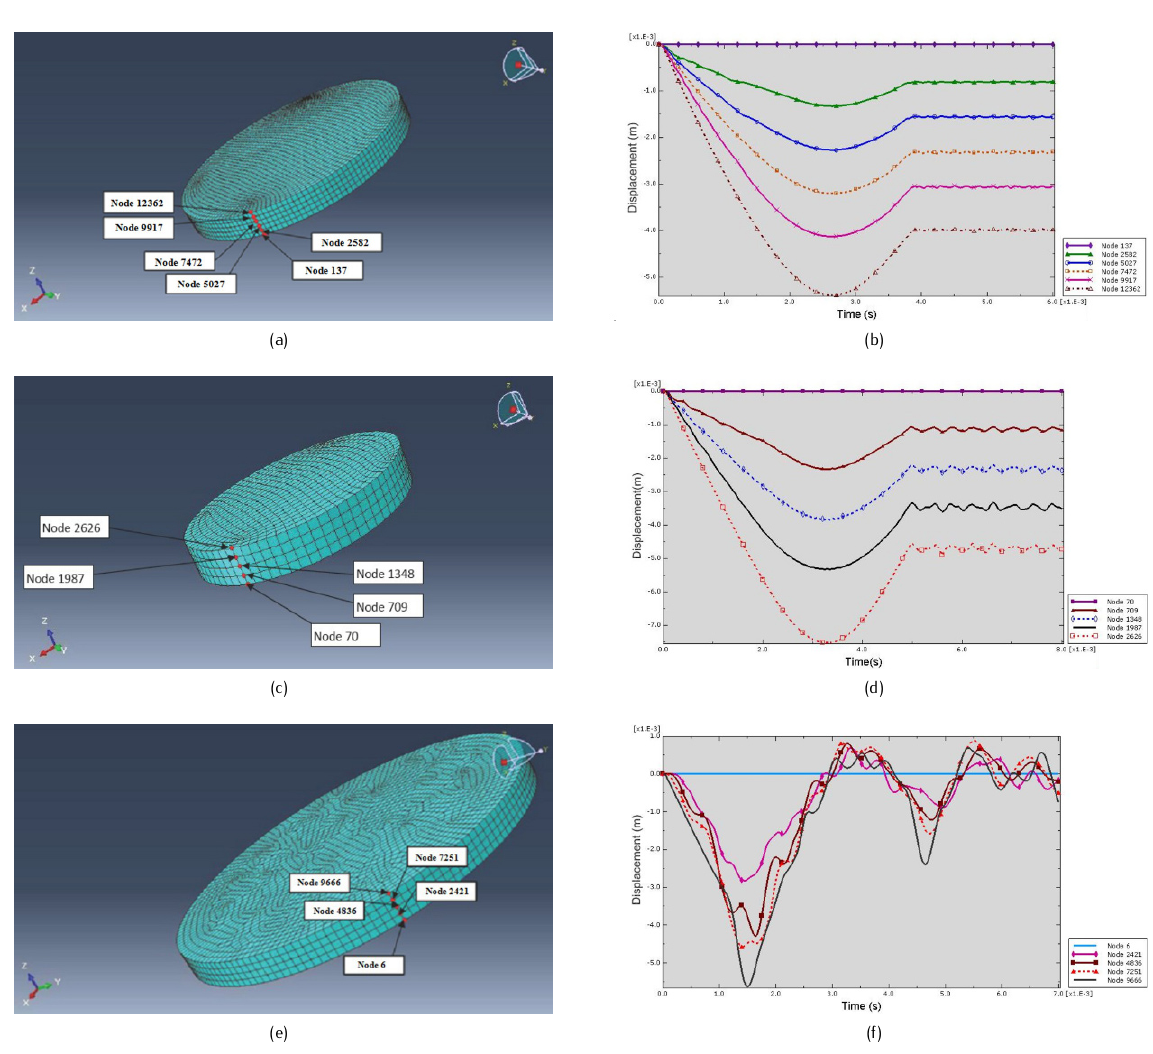
Figure 17. Compression profile: general views (a) EPP (c) PUR (e) EPDM; displacement versus time plots: (b) EPP, (d) PUR, (f) EPDM.